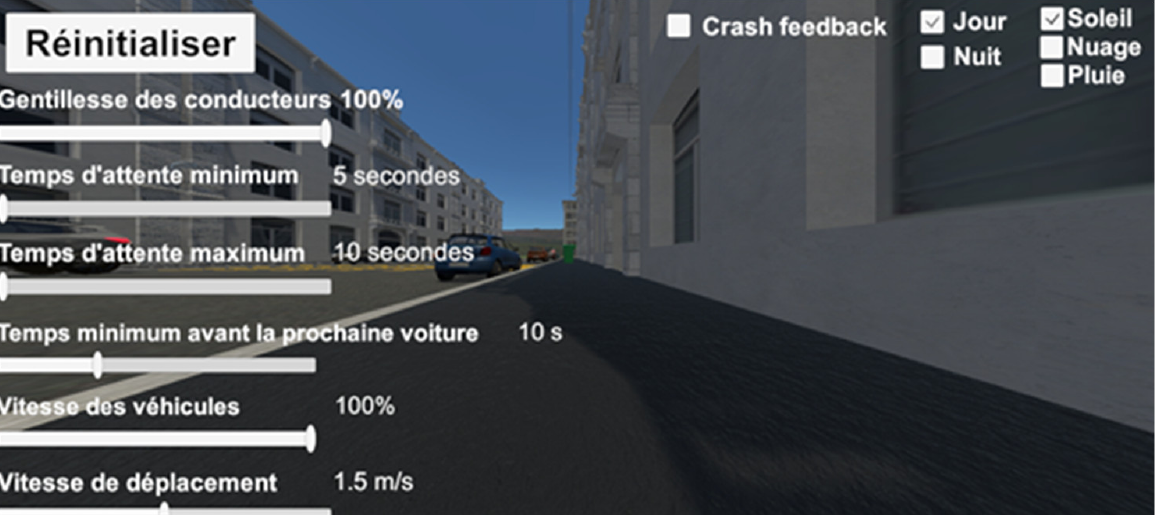
Figure 2. Overlay example for one scenario (with drivers’ kindness, minimum waiting time, maximum waiting time, minimum time before next vehicle, vehicle speed, travel speed, day/night, and sunny/cloudy/rainy). The application architecture is composed of a base layer common to all scenarios. This layer includes the following.